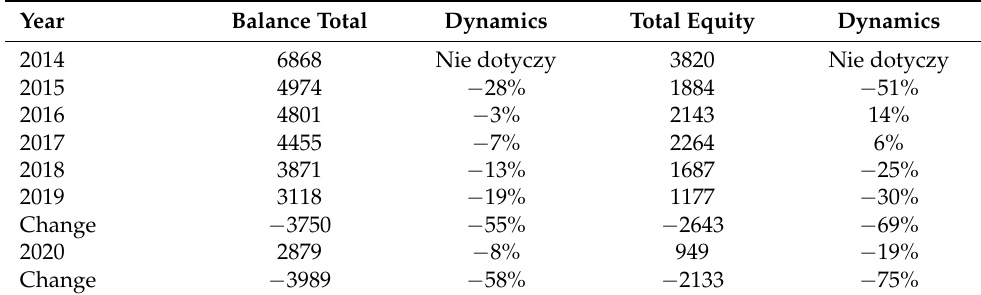
Table 13. Balance sheet total and equity of the ZE PAK capital group in the years 2014–2020 (in PLN